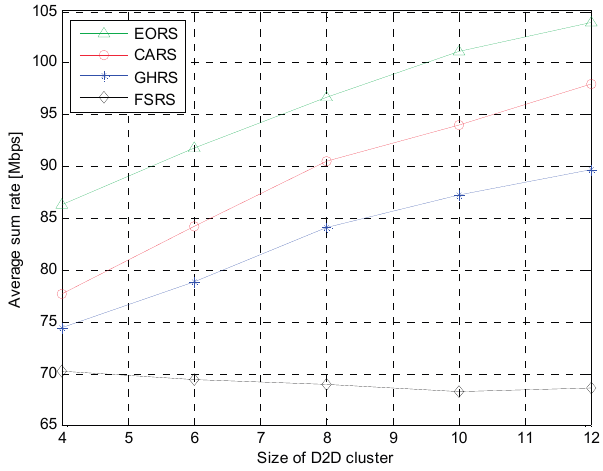
Figure 4. System mean data rate for different relay selection algorithms with different size of D2D cluster, where N ACK : N NACK =